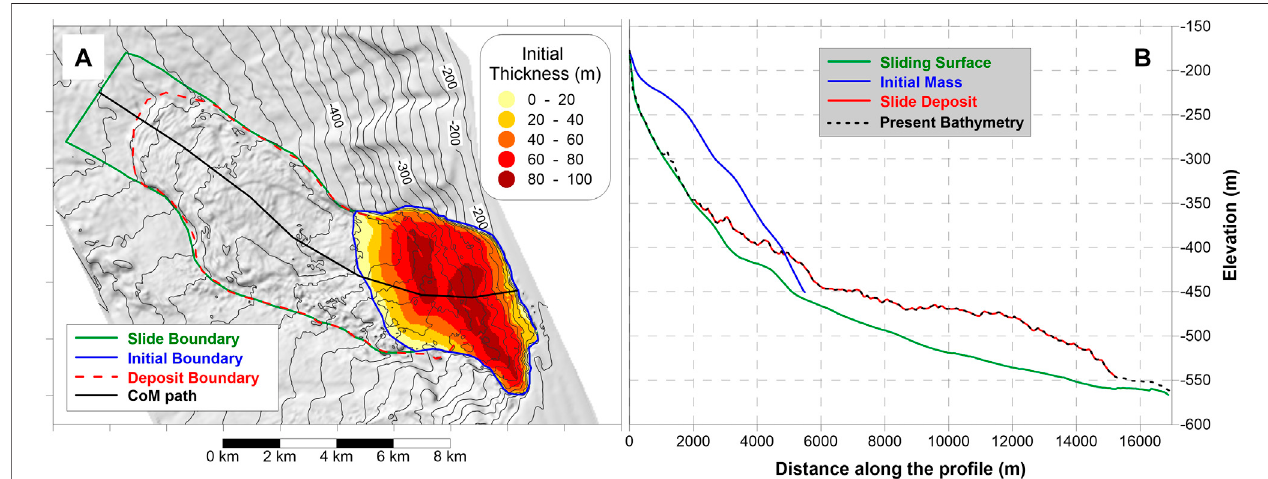
FIGURE3|(A) BathymetricmapoftheSGBSscenario,withtheinitialmassboundarymarkedinblueandobserveddepositindashed-red.Theresultinginitialslide thickness is marked by the yellow-red-brown color scale. The other input for the simulation code, the lateral slide boundaries, and the CoM prede fi ned trajectory, are reportedingreenand blackrespectively. (B) Morphological slicealongtheCoMpath. Inbluethe initialslidepro fi le,inred theobserveddeposit. Thegreenlinemarksthe undisturbed gliding surface, the black-dashed line the present